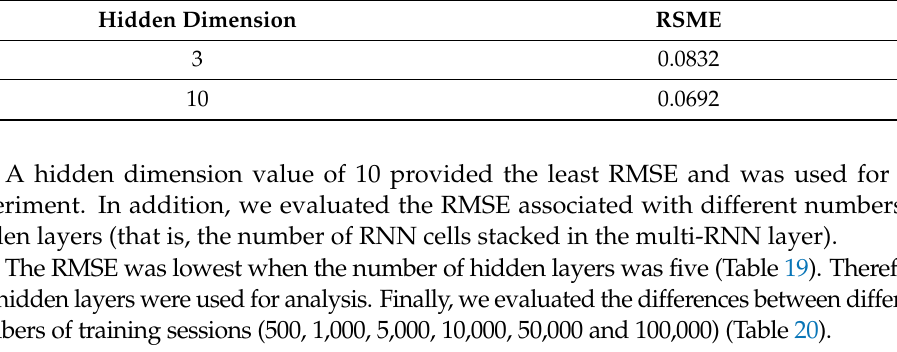
Table 18. Root mean squared error (RMSE) values based on the value of the hidden dimension.